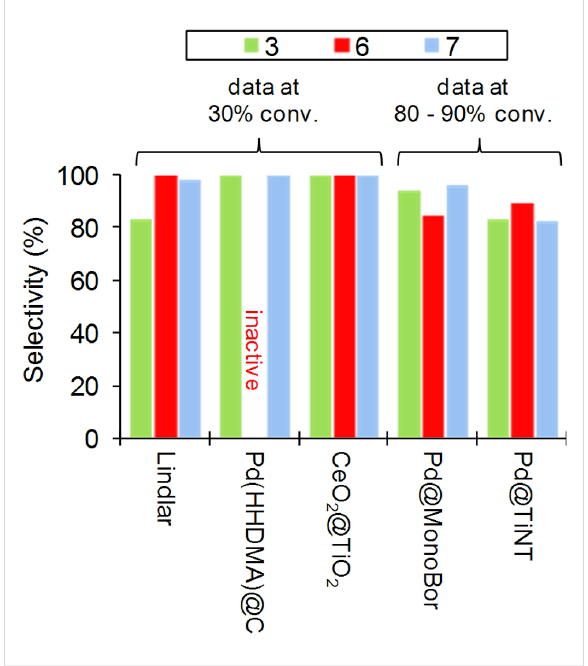
Figure 9: Continuous-flow hydrogenation of 3 , 6 and 7 over different catalytic reactor systems. Data from refs.